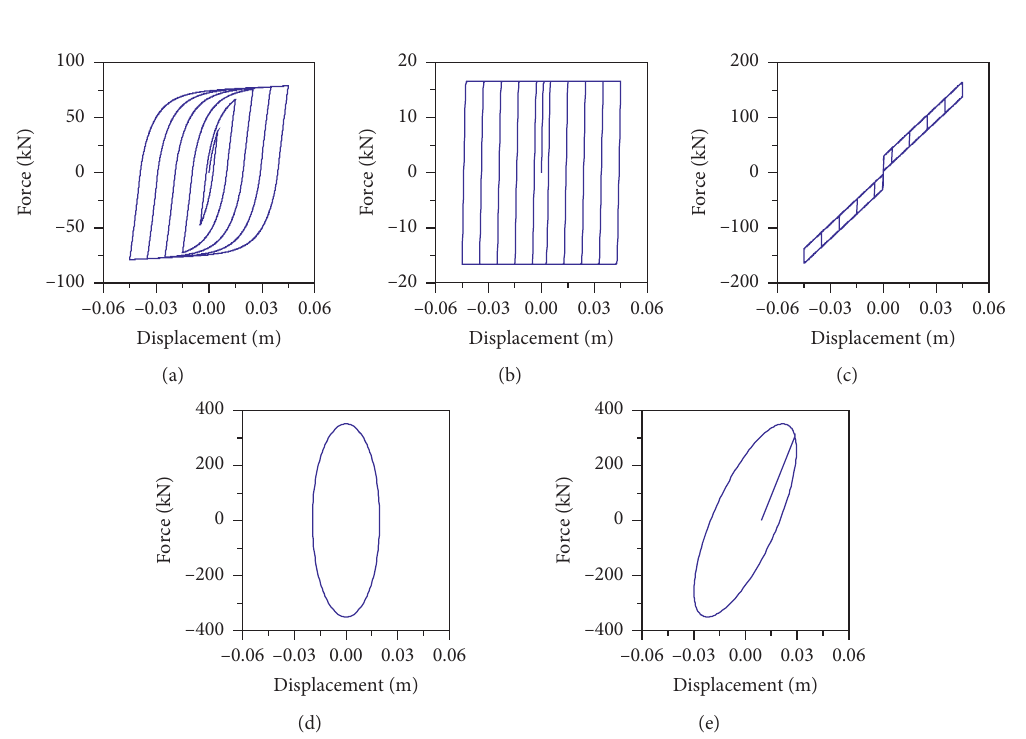
Figure 3: Hysteresis curves of five typical dampers: (a) BRB; (b) FD; (c) SCD; (d) VD; (e) VED.